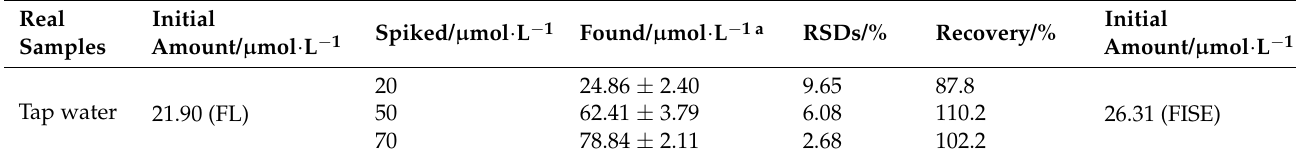
Table 2. Standard addition assays based on fluorescent SiNPs in tap